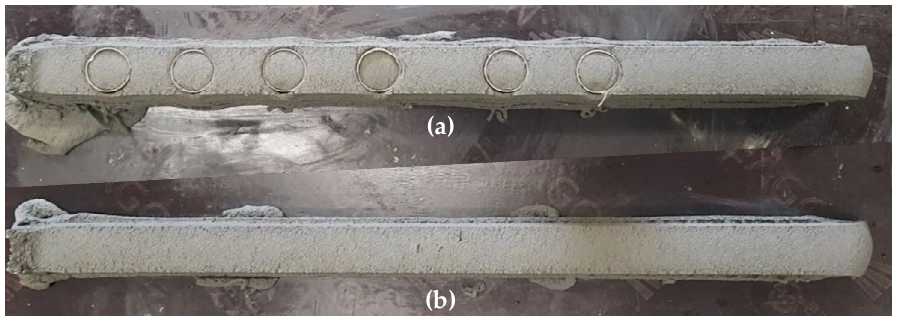
Figure 3. Parts additively manufactured in air: ( a ) AP-4La; ( b ) AP-2La.